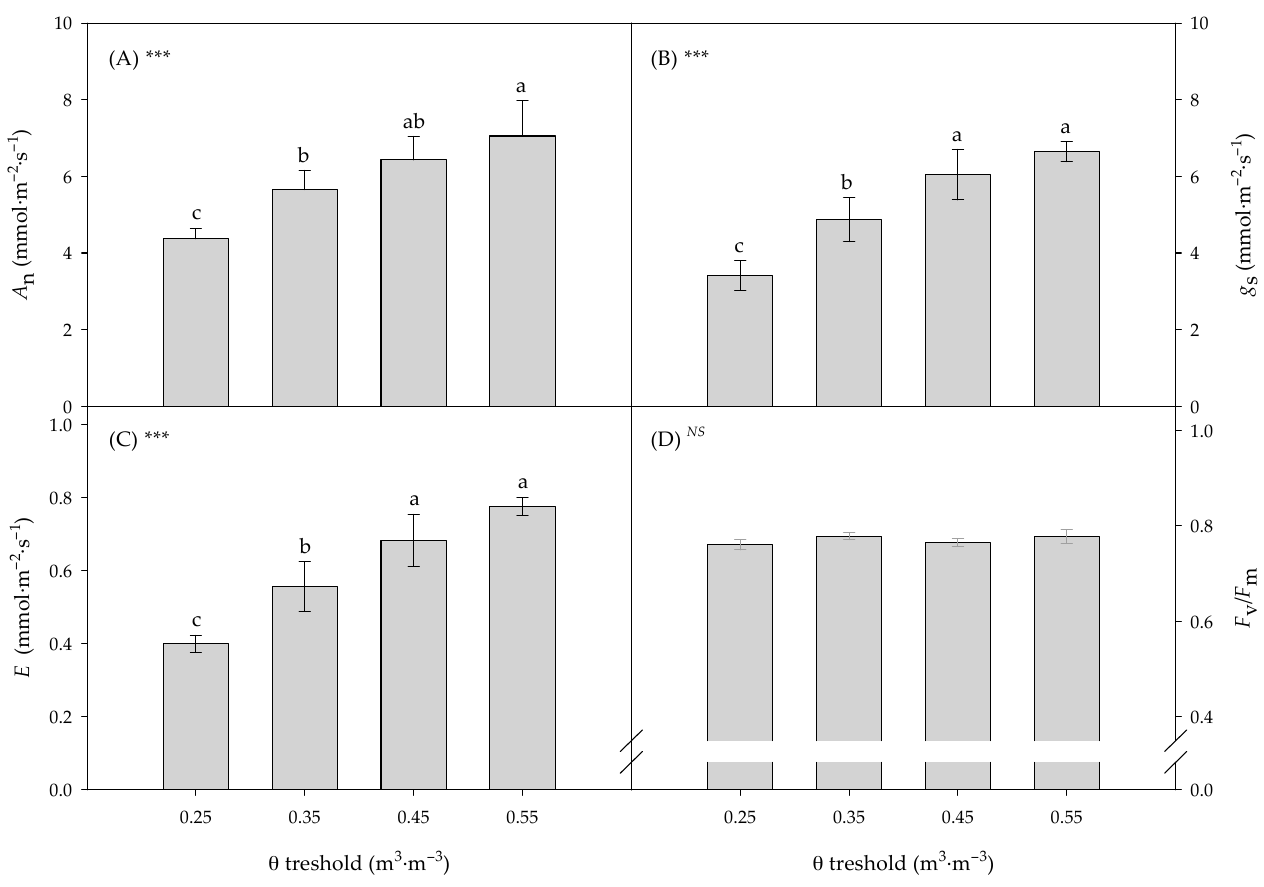
Figure 4. Net CO 2 assimilation rate (A n , ( A )), stomatal conductance (g s , ( B )), transpiration rate (E, ( C )), and maximum quantum efficiency of photosystem Ⅱ ( F v / F m , ( D )) in the uppermost mature leaves of 1-year-old cymbidium “Hoshino Shizuku” after 41 weeks under 0.25, 0.35, 0.45, and 0.55 θ thresholds (m 3 ·m − 3 ). Mean separation by Duncan’s multiple range test at α = 0.05. NS and *** indicate non-significance and significance at p < 0.001. Error bars indicate SE ( n = 9). Table 3. Irrigation amount, water use efficiency (WUE) of 1-year-old cymbidium “Hoshino Shizuku” at the harvest after 42 weeks of treatments, as influenced by 0.25, 0.35, 0.45, and 0.55 θ thresholds (m 3 ·m − 3 ).